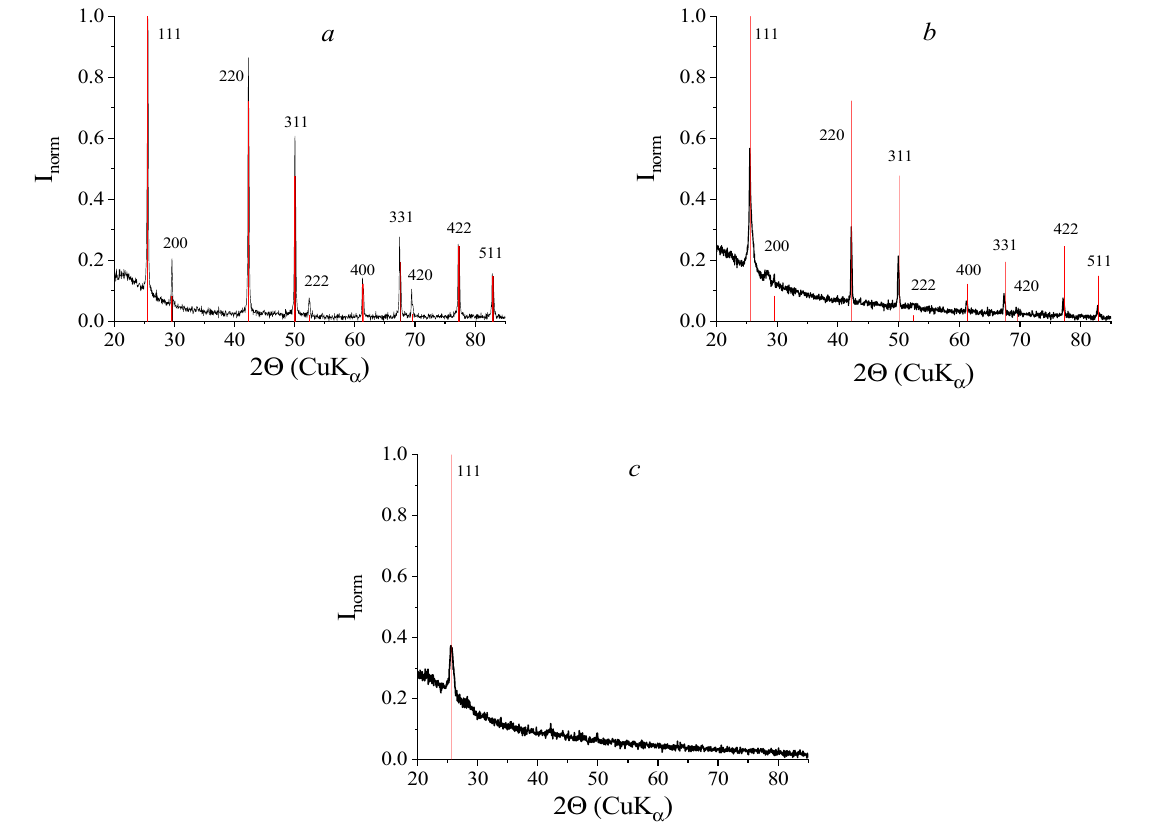
Figure 4. XRD-pattern recorded from the rinsed CuI-PPy samples: ( a )—1–5, ( b )—6, ( c )—7. Bars corresponded to CuI structure in accordance with JCPDF N° 83–1137. Note: the halo in the area of 20° is corresponding to the presence of amorphous PPy.